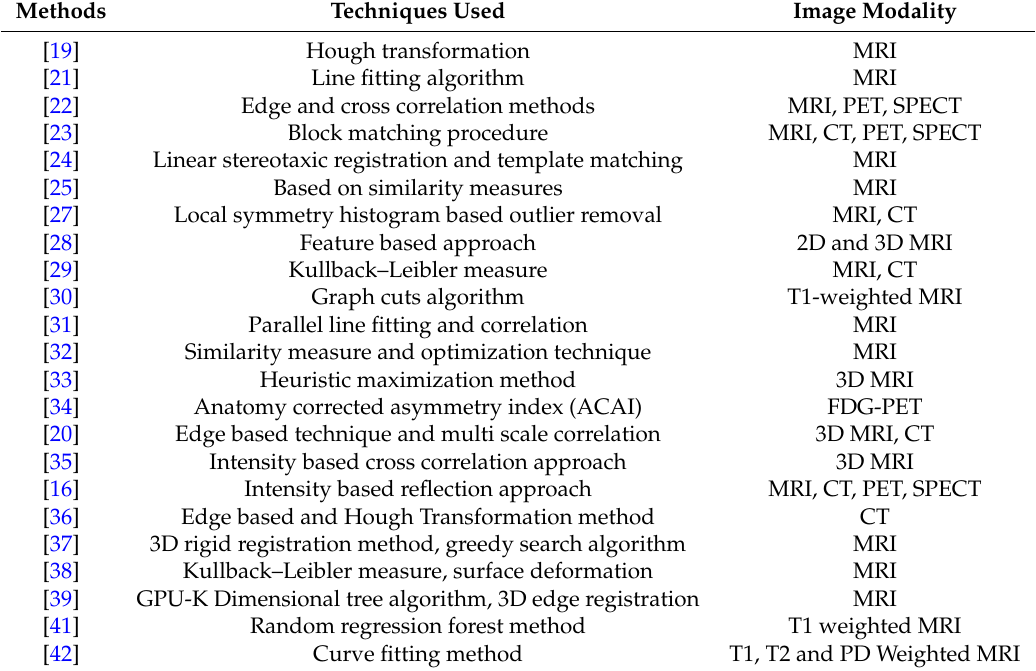
Table 1. Summary of the existing mid-sagittal plane (MSP) based methods and approaches for brain symmetric and asymmetric